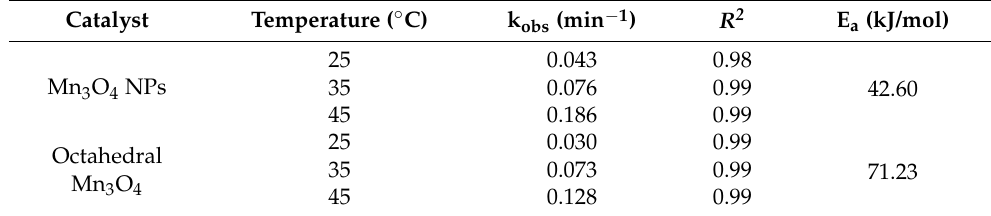
Figure 6. Effect of temperature on phenolic degradation in catalytic oxidation using ( a ) octahedral Mn 3 O 4 ( b ) Mn 3 O 4 NPs. Reaction condition: phenol concentration = 25 ppm, catalyst = 0.4 g/L, PMS = 2 g/L. Table 2. Kinetic constants of phenol degradation at different temperatures on α -Mn 3 O 4 catalyst. Catalyst Temperature ( ◦